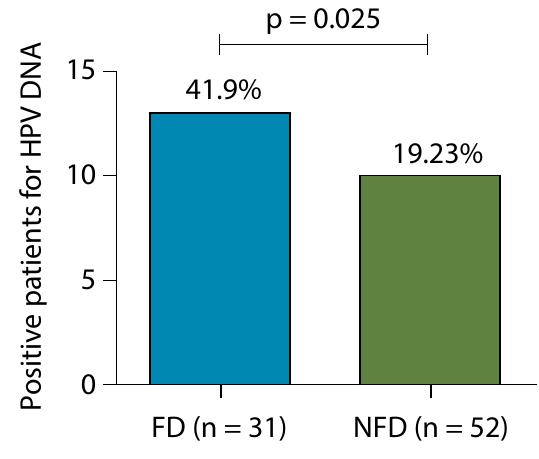
Figure. Distribution of patients positive for HPV-DNA. FD: patients who use full denture and are positive for HPV-DNA. NFD: patients who do not use full denture and are positive for HPV-DNA. *p = 0.025. Pearson’s Chi-square test